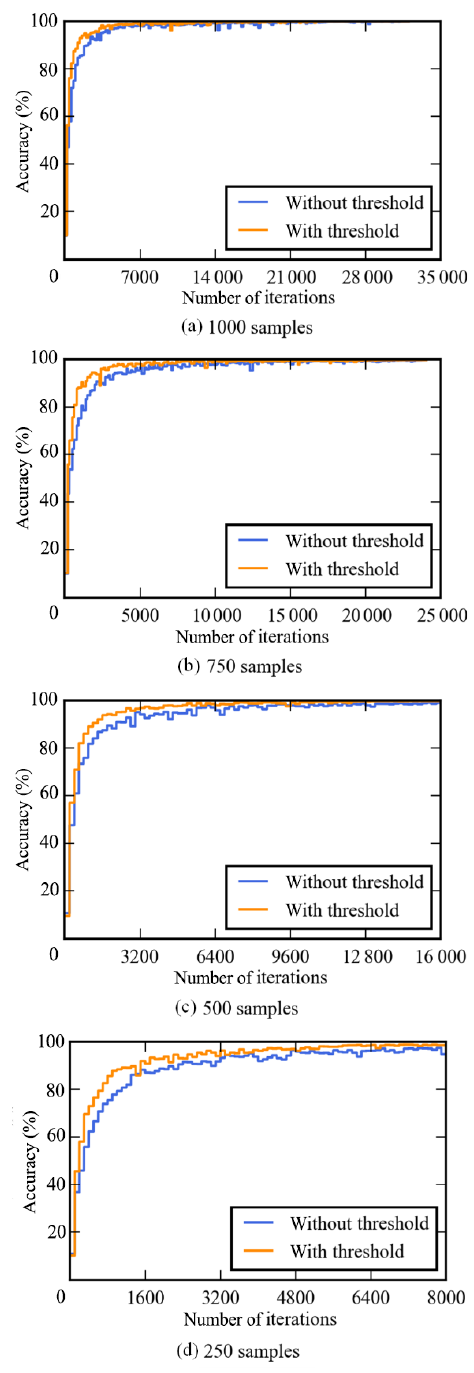
Fig. 7 Accuracy comparisons with/without threshold under different capacities of limited labeled datasets in Case